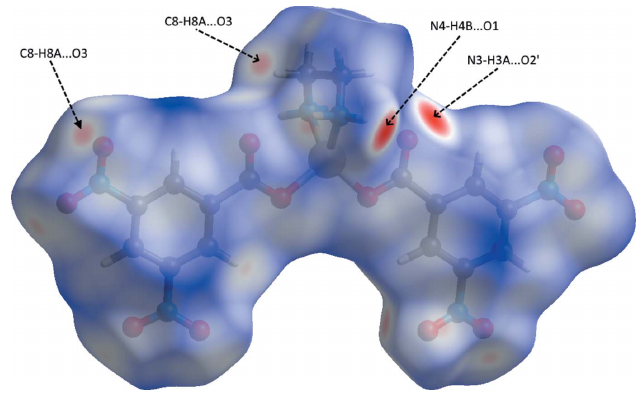
Figure 3 View of the three-dimensional Hirshfeld surface of the title compound plotted over d norm in the range (cid:3) 0.4180 to 1.3344 a.u.